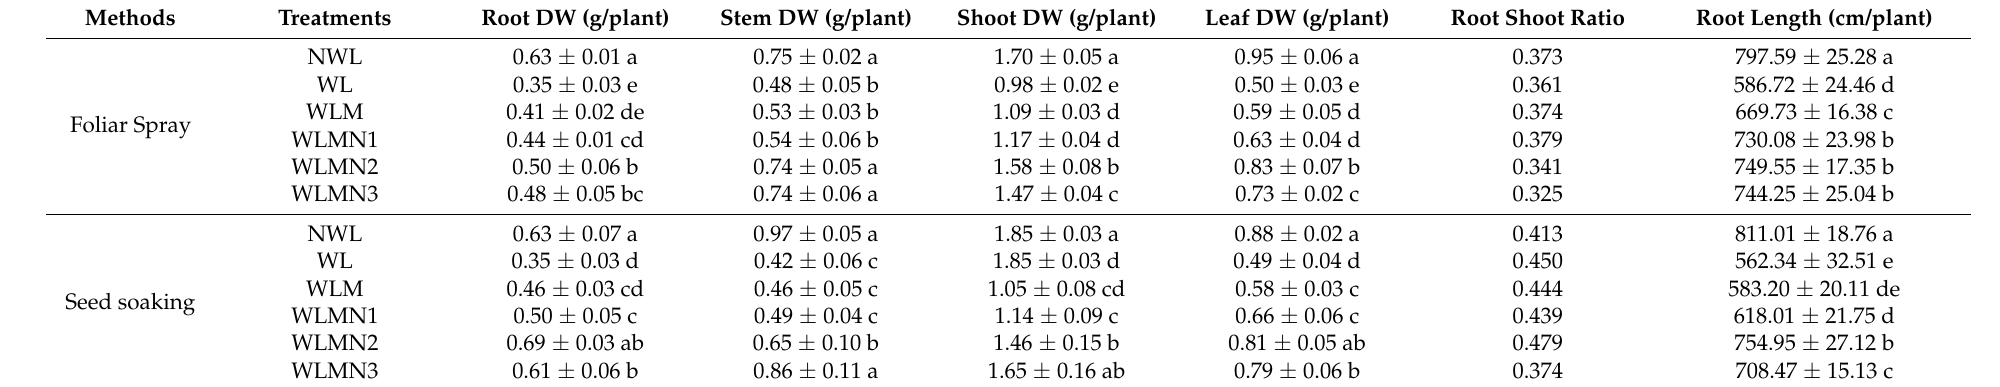
Table 2. Effect of melatonin with KNO 3 on dry matter accumulation of root, stem, shoot, leaf, root to shoot ratio and root length of maize seedlings under waterlogging stress